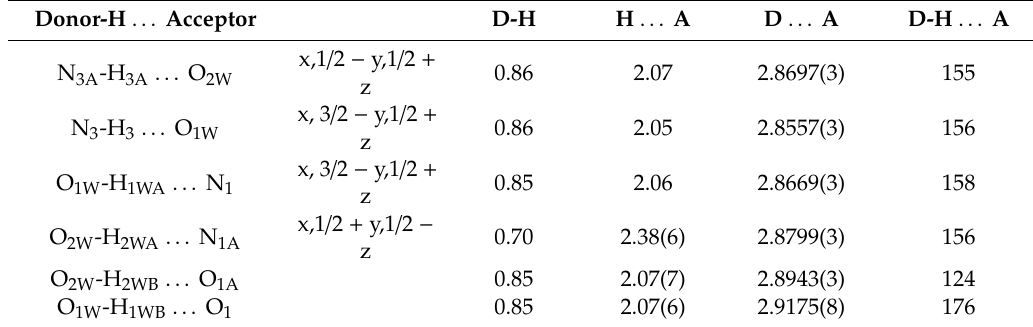
Table 6. Some important intermolecular interactions in APH